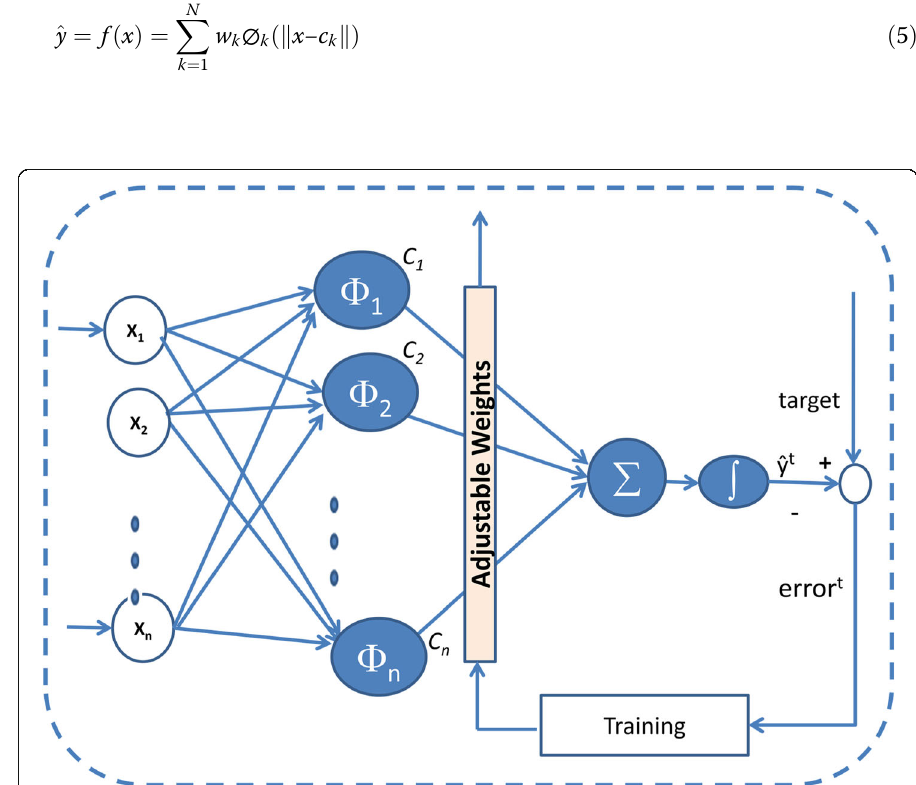
Fig. 3 RBFNN based Forecasting